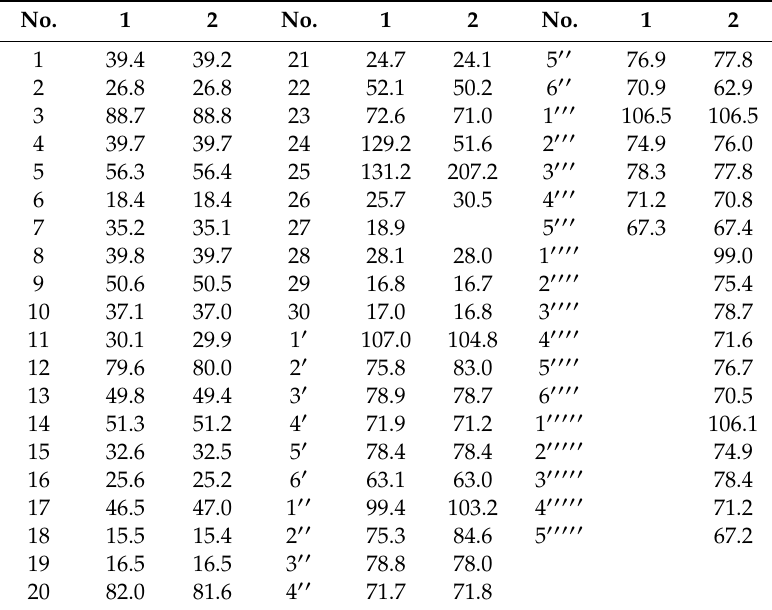
Table 1. 13 C NMR data of 1 and 2 in C 5 D 5